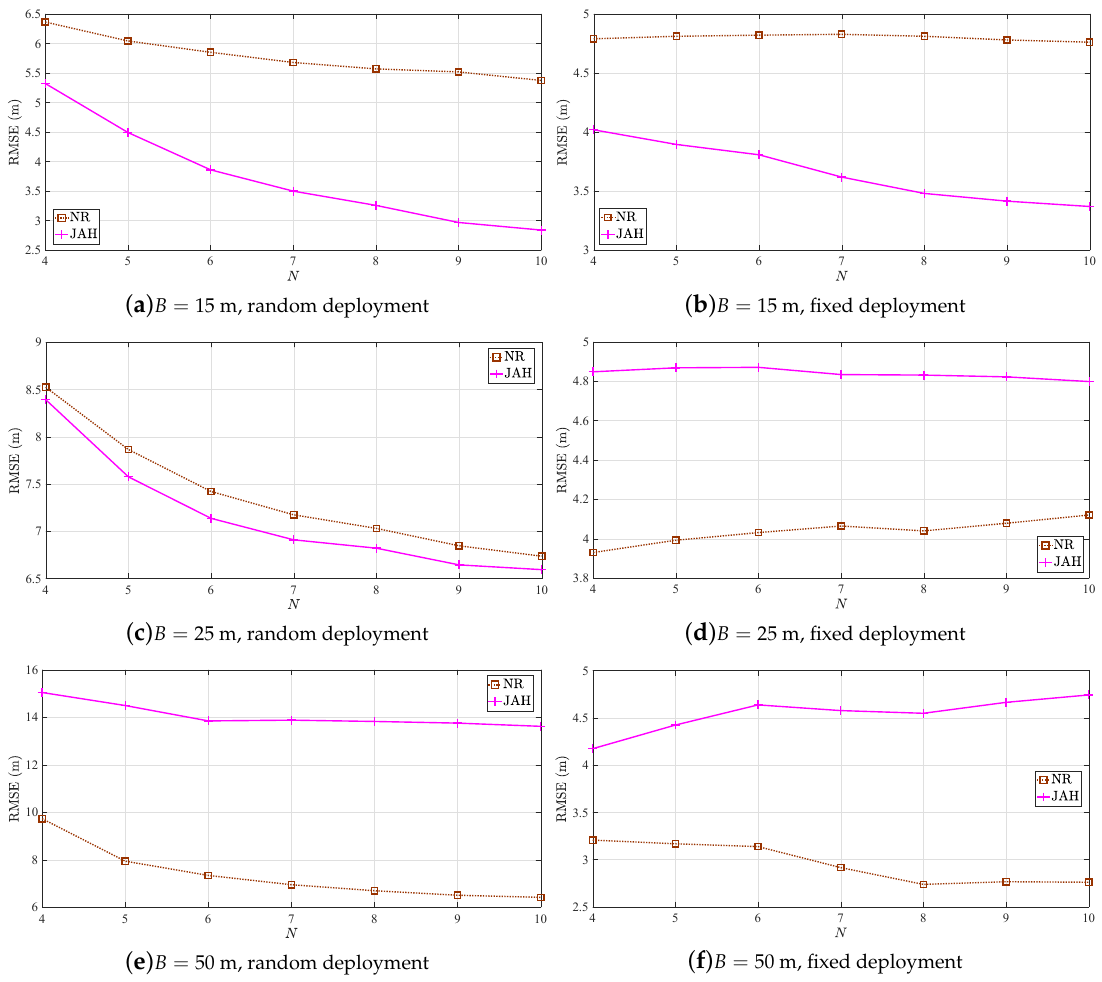
Figure 5. RMSE versus N comparison for NR and